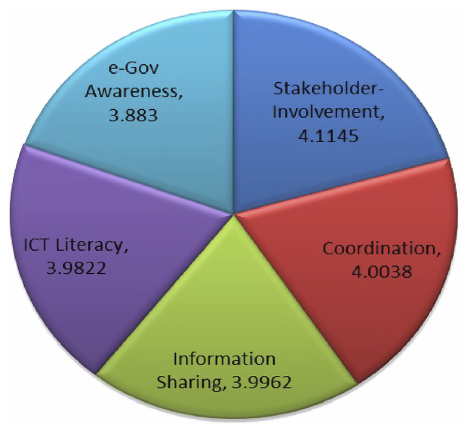
Figure 7. The most major five challenges